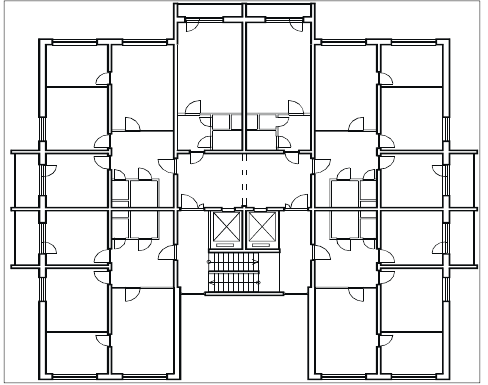
Figure 2. Prefab panel construction system known as T06B-OS, the plan is highly articulated, creating considerably cooled surfaces in the peripheral circumferential shell (Photo source: Author’s archive [29,30]).